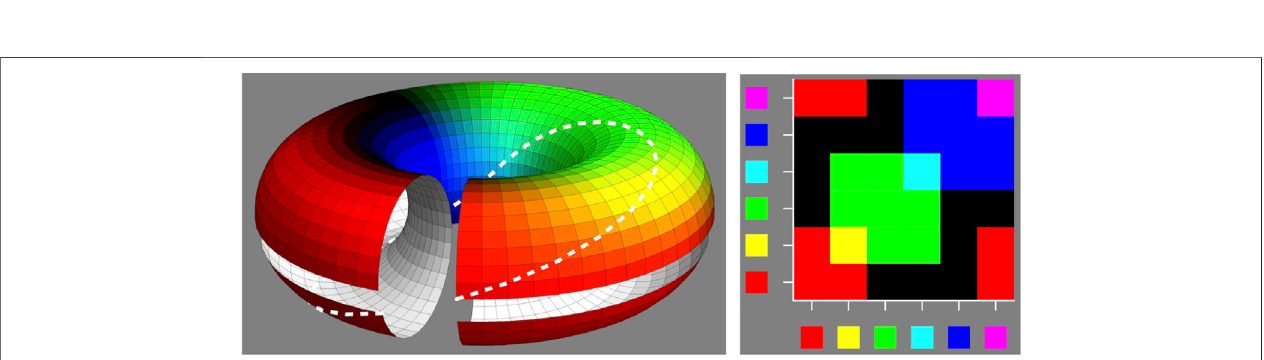
FIGURE 13 | The Tropaeolum majus is also known as Indian cress. It is mainly valued for its brilliant orange or red fl owers. Here the spectral re fl ectance factor is approximatedbythecanonicalRGB-re fl ectance and theOstwald attenuated and dilutedfullcolorspectrum.Both arequitegood approximations.All threespectra yield exactly the same color.